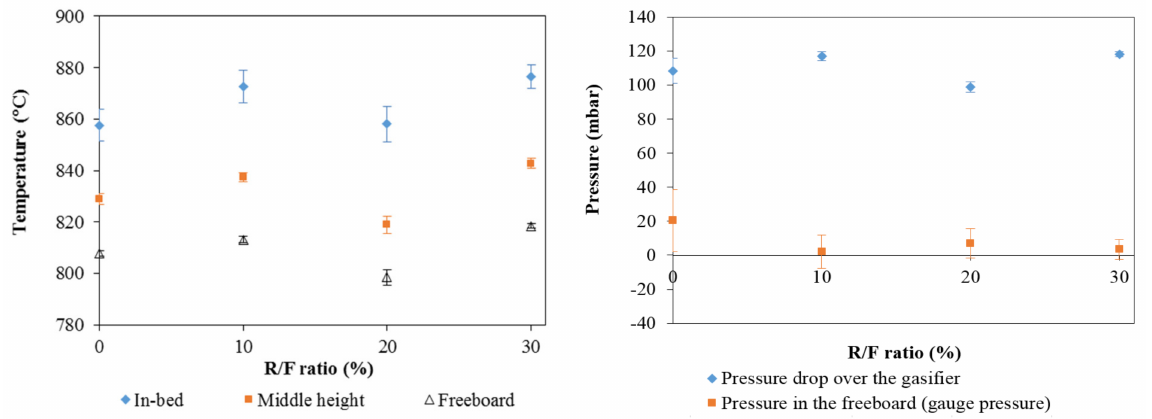
Figure 7. Influence of R/F ratio on the BFB gasifier temperature and pressure at different heights of the reactor.